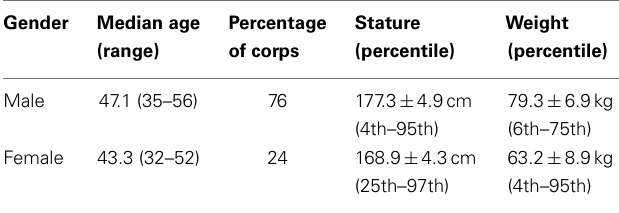
Table 2 | NASA astronaut corps, gender, and anthropometric distribution (as of